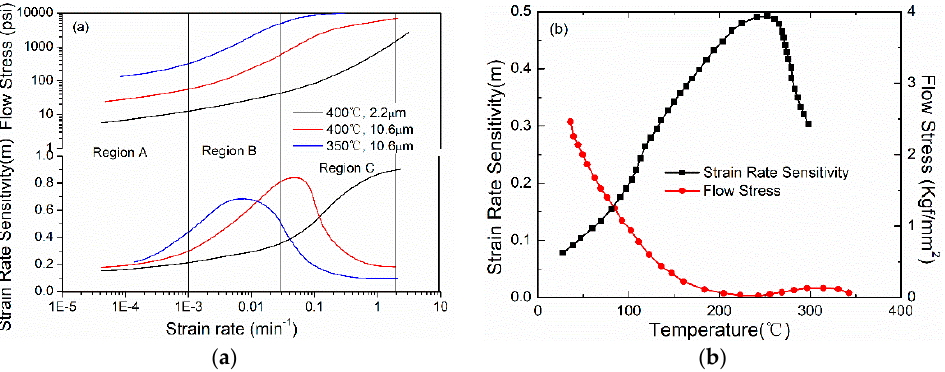
Figure 12. ( a )Variation of strain rate, flow stress and strain rate sensitivity (m) at different temperatures and grain sizes, reproduced from [36], with permission from Elsevier, 1969; ( b ) relation between flow stress, strain rate sensitivity, and temperature, reproduced from [128], with permission from Elsevier, 1982.